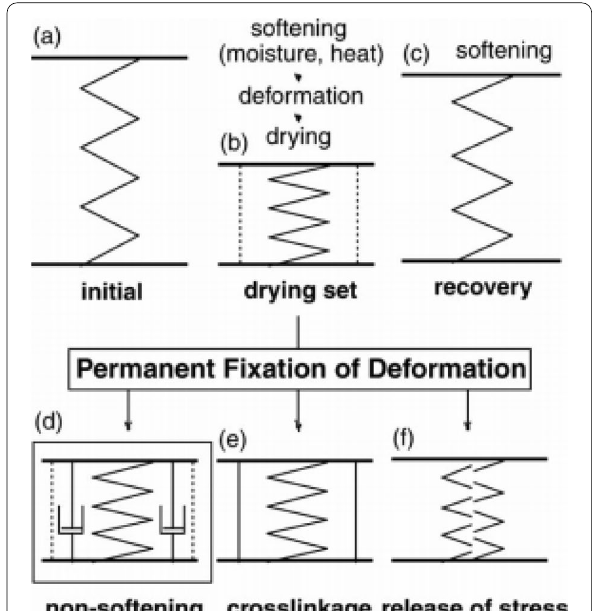
Fig. 11 Mechanisms of permanent fixation of deformation